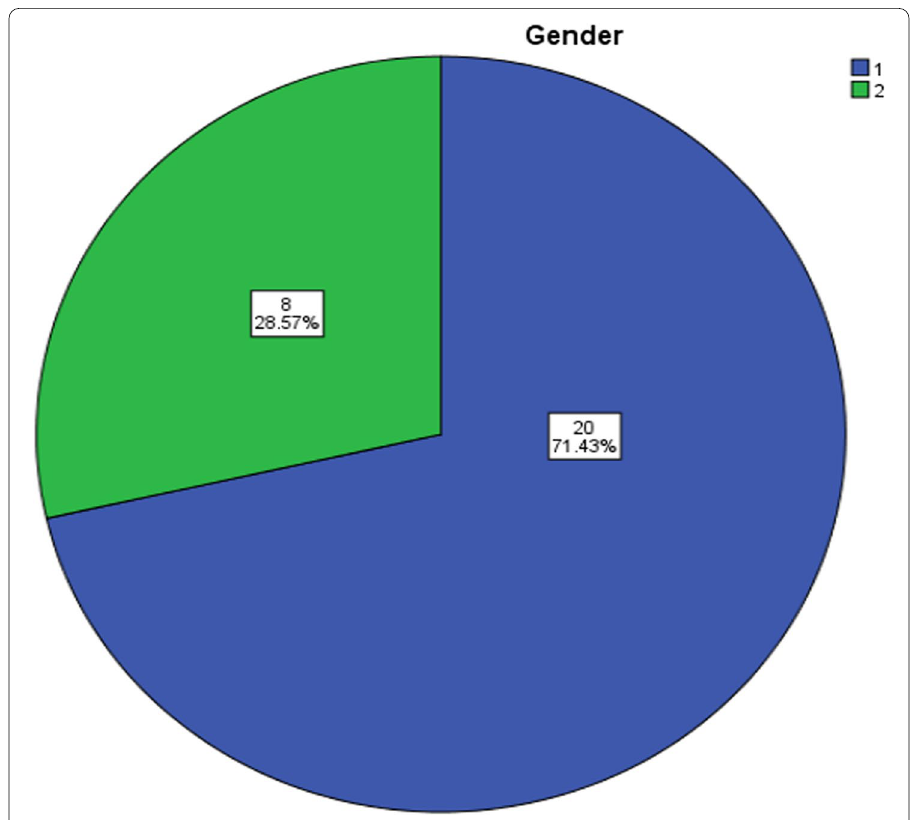
Fig. 3 Gender. Source: SPSS 23.0 output